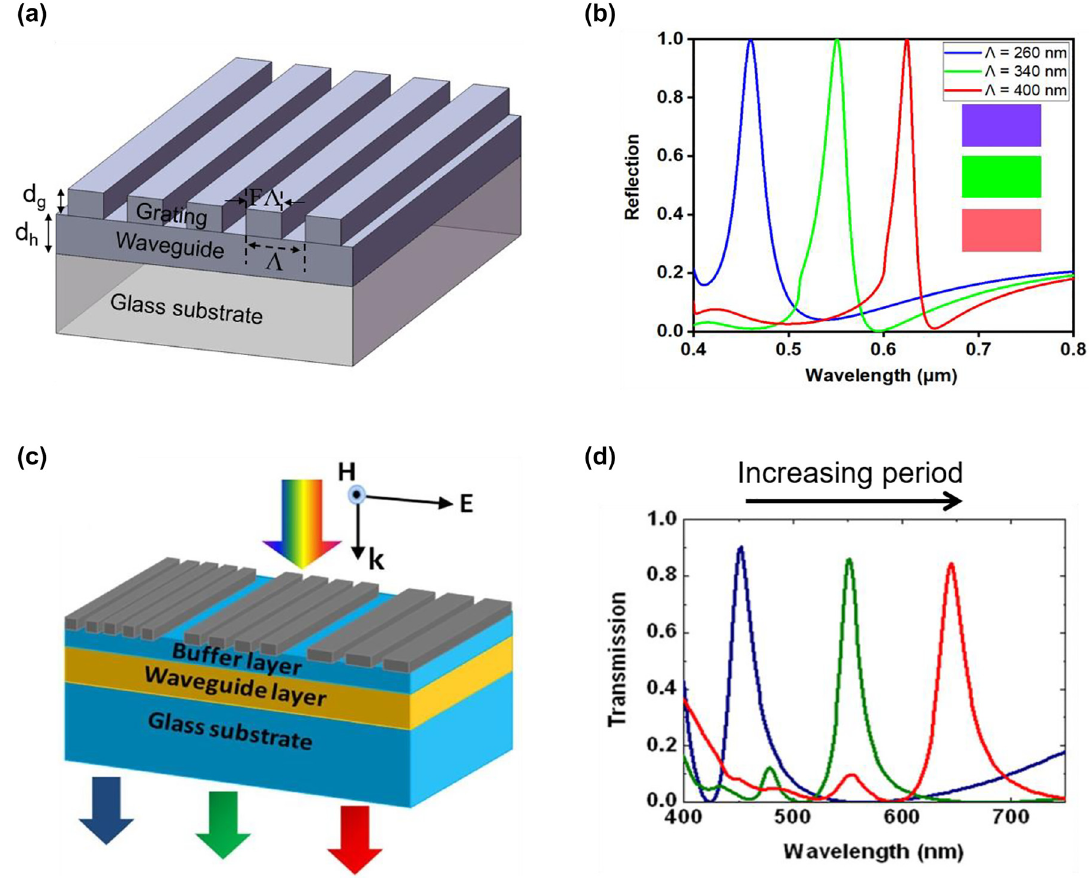
Figure 9: Guided mode resonance for structural color generation. (a) Schematic diagram of a representative GMR-based structural color device, consisting of a grating layer, a waveguide layer, and a substrate. d and d represent the grating depth and planar waveguide thickness, respectively. g h F denotes the grating filling ratio, defined as the ratio of its width to period. (b) Calculated reflection spectra of three GMR devices under normally- = 80 nm) patterned gratings ( d incident TM polarized light (with electric field oscillating perpendicular to the 1D grating). The device consists of TiO 2 g = 60 nm) on a glass substrate. The grating period ( Λ ) is respectively chosen as 260 nm, 340 nm, and 400 nm, waveguide layer ( d over a thin TiO 2 h while the filling ratio ( F ) is fixed as 0.5 for all three samples. Inset shows the perceived colors based on the reflectance spectra. (c) Schematic buffer layer, a Si N waveguide layer, and illustration of a transmission-type GMR-based structural color device, comprising an Ag grating layer, a SiO 2 3 4 a glass substrate. (d) Calculated transmission spectra under TM polarized normal incidence. In the calculation, the filling ratio is fixed as 0.75, and the grating periods for RGB colors are respectively chosen as 280 nm, 340 nm, and 400 nm. Thicknesses of grating layer, the buffer layer, and the waveguide layer are set as 40 nm, 50 nm, and 100 nm, respectively. Modified with permission [128]. Copyright 2011, American Institute of